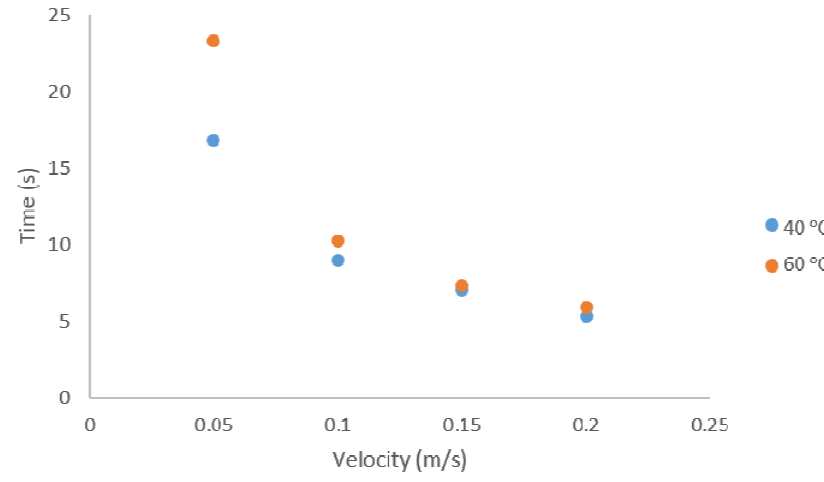
Figure 9. Time taken for 10% of the SO 2 to break through the top of the bed.